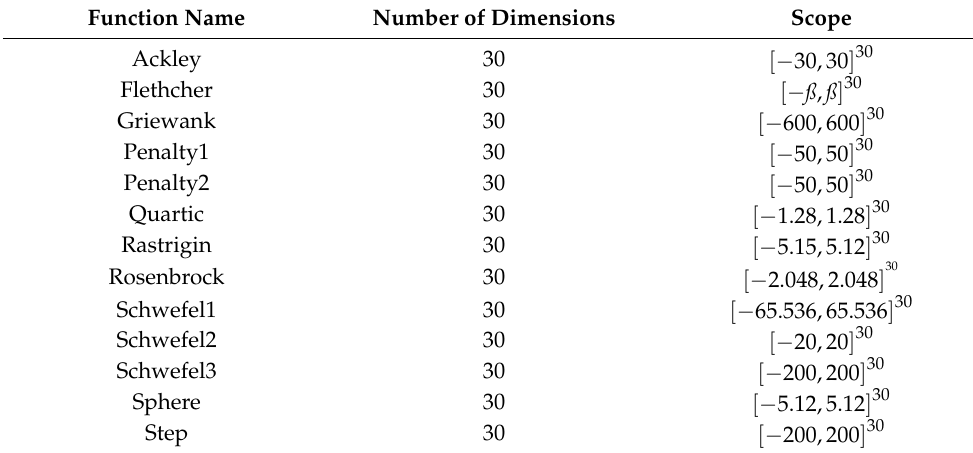
Table 1. The 13 standard benchmark